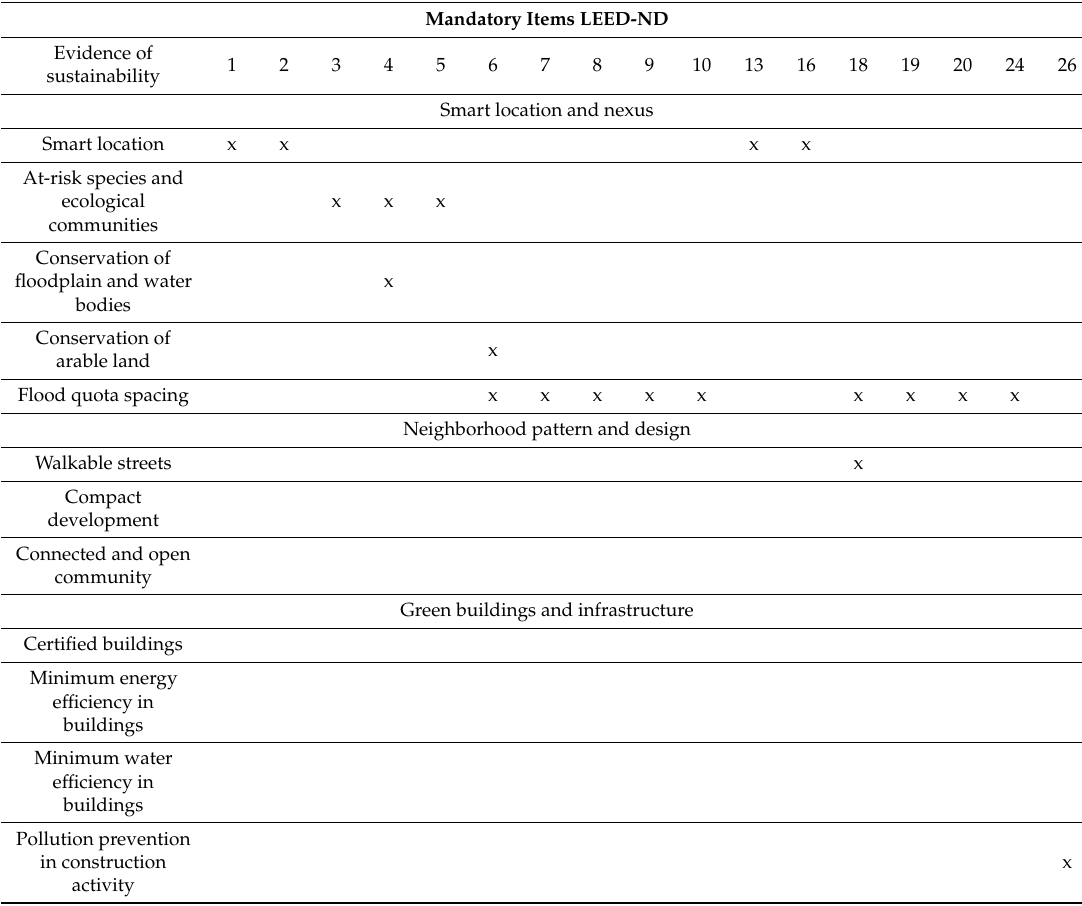
Table 4. Correlation of sustainability: mandatory